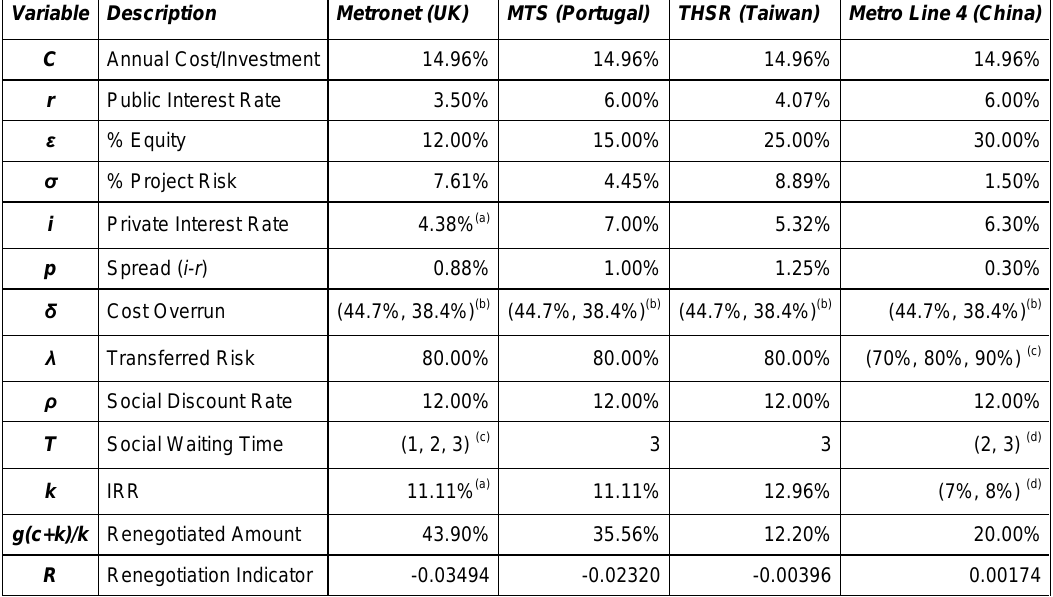
Table 3. Parameters of the four case